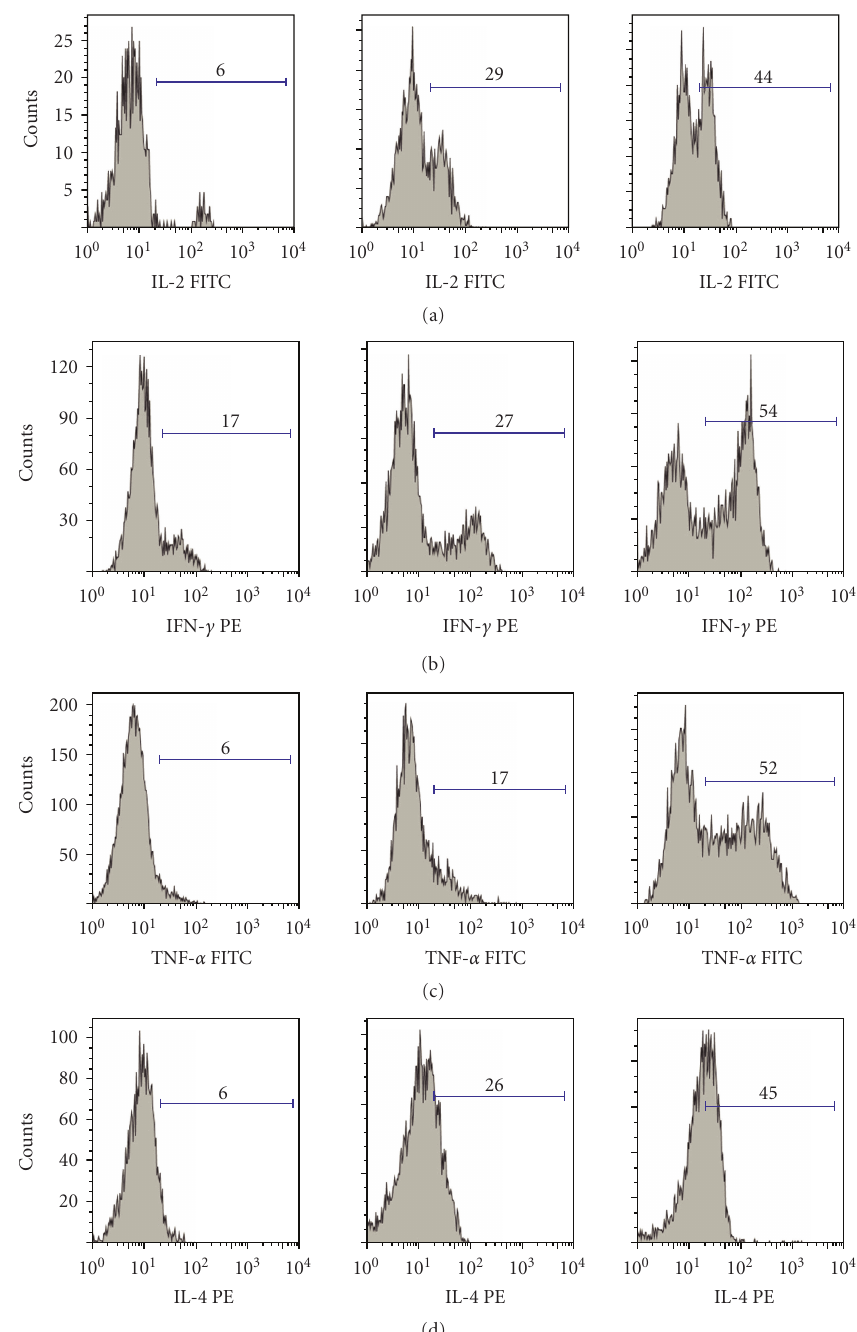
Figure 1: Analysis of intracellular cytokine staining of IL-2, IFN- γ , TNF- α , and IL-4 from gated CD3+CD4+, respectively.